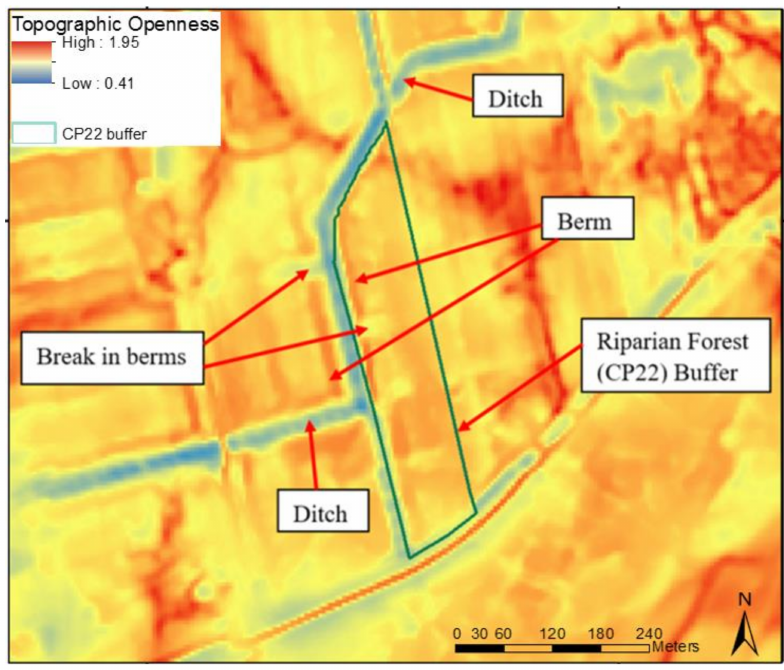
Figure 7. A close-up of hydrologic features such as berms and ditches identified using topographic